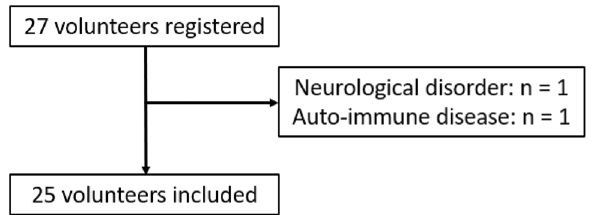
Figure 2. Flow chart of patient selection and exclusion.